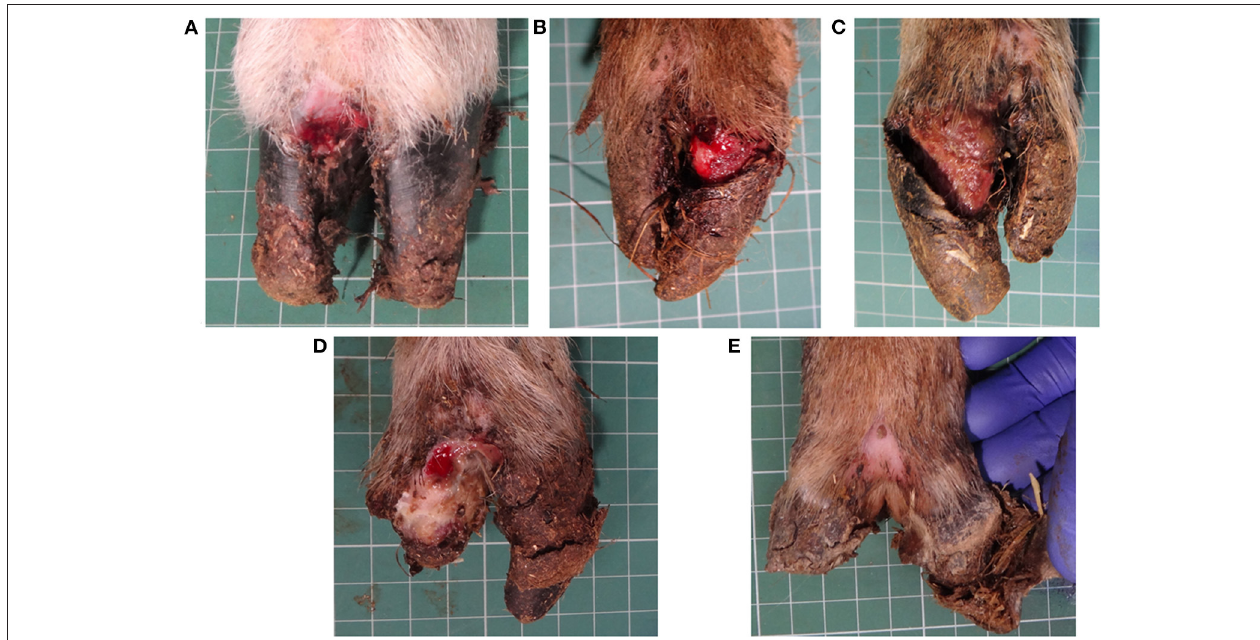
FIGURE 1 | CODD G#1 (A) , CODD G#2 (B) , CODD G#3 (C) , CODD G#4 (D) , and CODD G#5 (E)